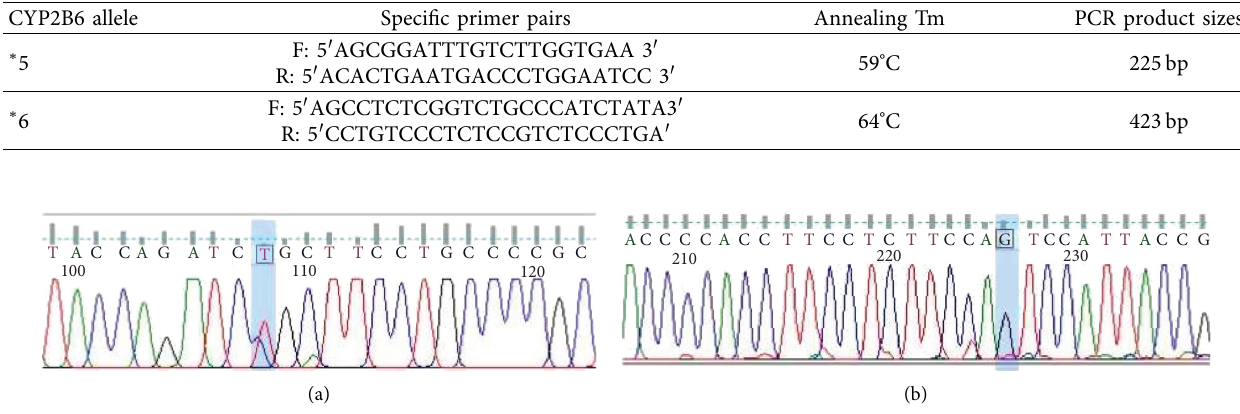
Figure 2: DNA sequence chromatogram showing nucleotide change position. (a) A missense nucleotide transition C > T in c.1483 of CYP2B6 gene, a heterozygous sample for CYP2B6 ∗ 5 (rs 3211371) polymorphism. (b) A normal sample with major allele G in c.540 G > Tof CYP2B6 gene for CYP2B6 ∗ 6 (rs 3745374) polymorphism.